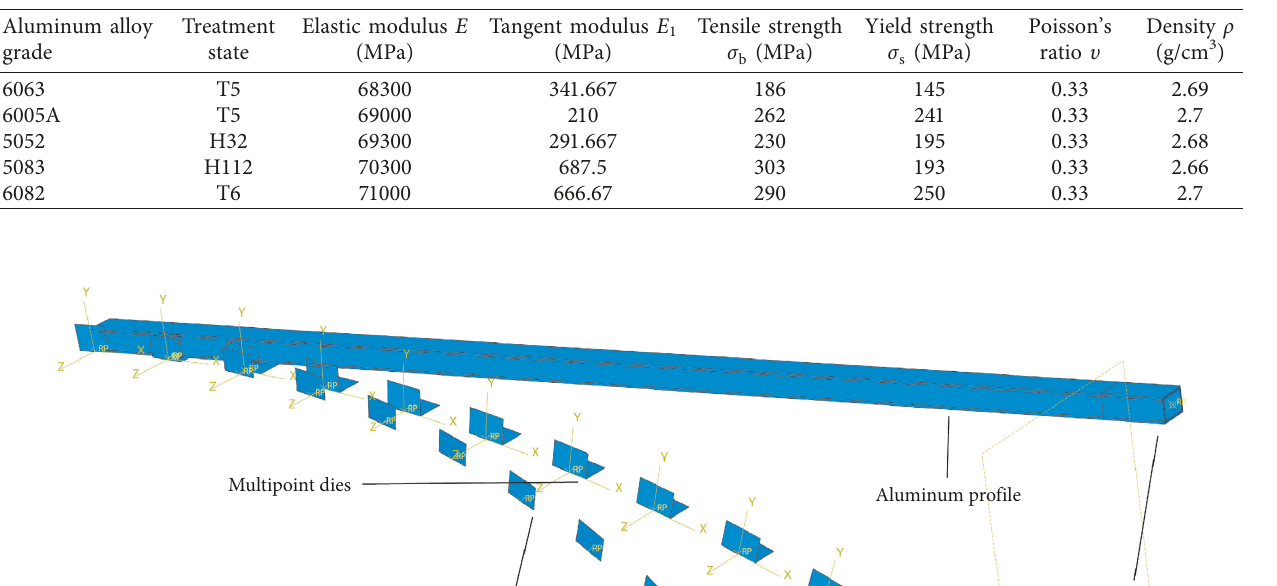
Figure 1: Schematic diagram of the flexible 3D multipoint stretch-bending equipment. (a) Bending forming in the horizontal direction. (b) Bending forming in the vertical direction. Table 1: Aluminum alloy grade and mechanical properties.